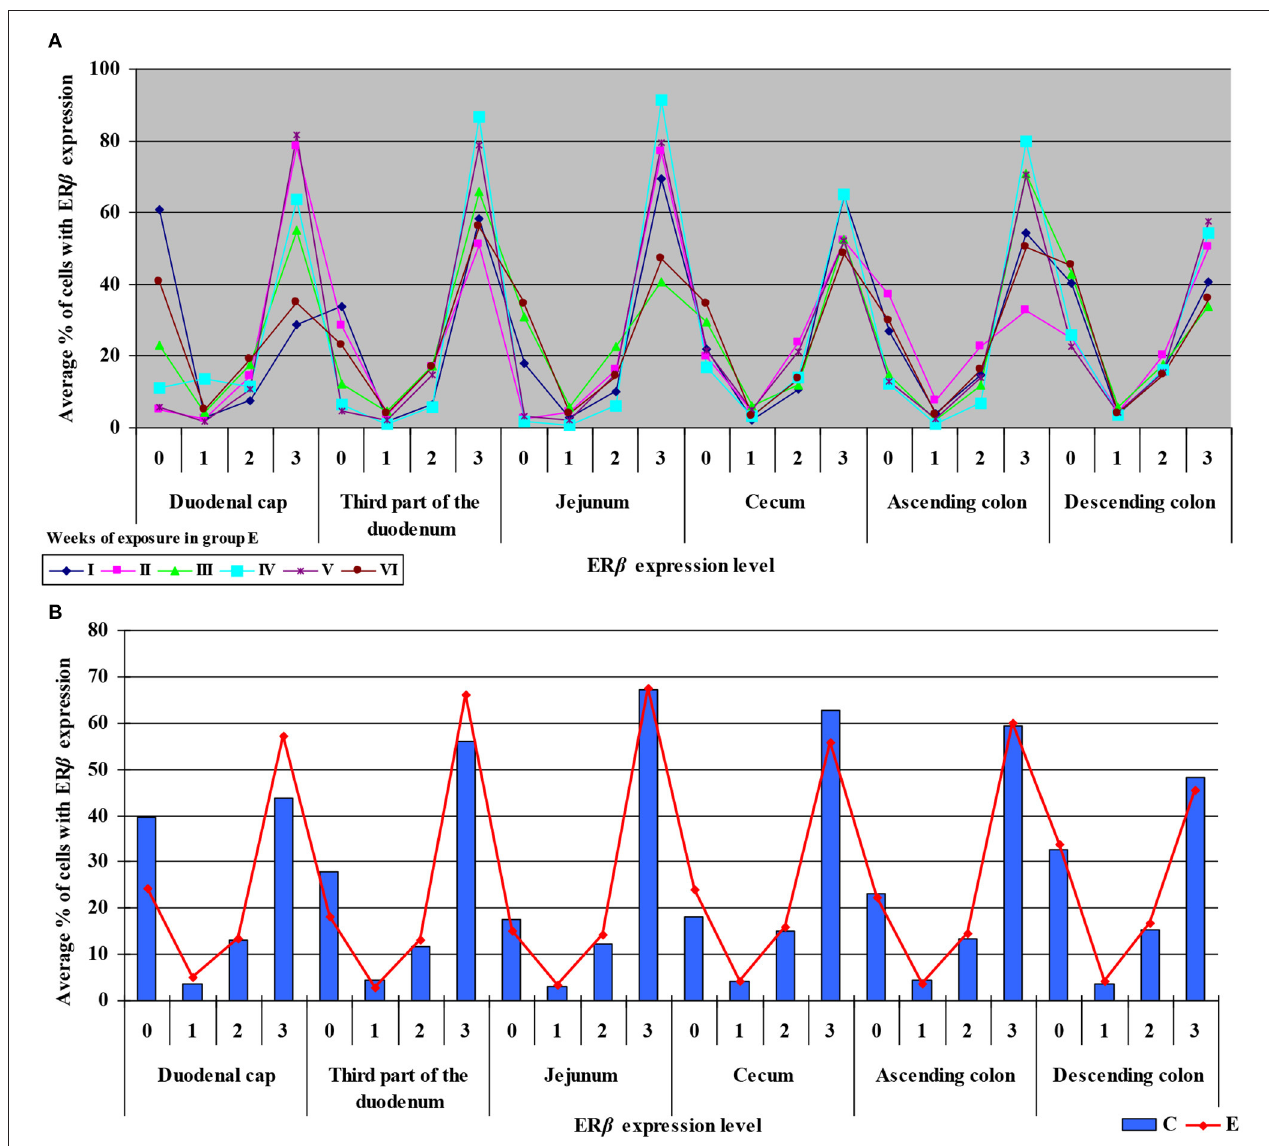
FIGURE 6 | Immunohistochemical expression of ER β in the control and exposed groups (graded on a 4-point scale: negative = 0 points; weak and homogeneous = 1 point; mild or moderate and homogeneous = 2 points; intense or strong and homogeneous = 3 points) in different intestinal segments and in selected weeks of exposure: (A) in group E; (B) average expression values from all weeks of exposure in both groups.